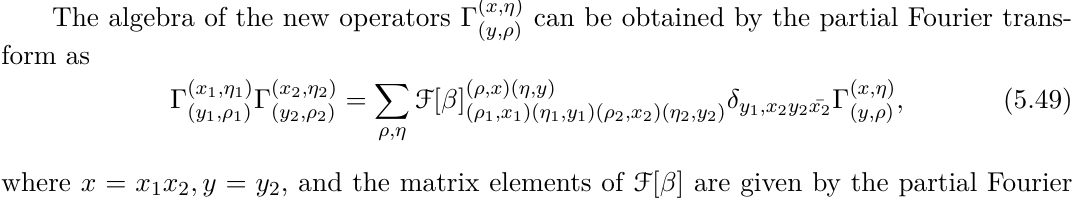
( g 1 , g 2 ) is depicted as three tetrahedra glued to- 2 ( ρ 1 ,x 1 )( η 1 ,y 1 )( ρ 2 ,x 2 )( η 2 ,y 2 )